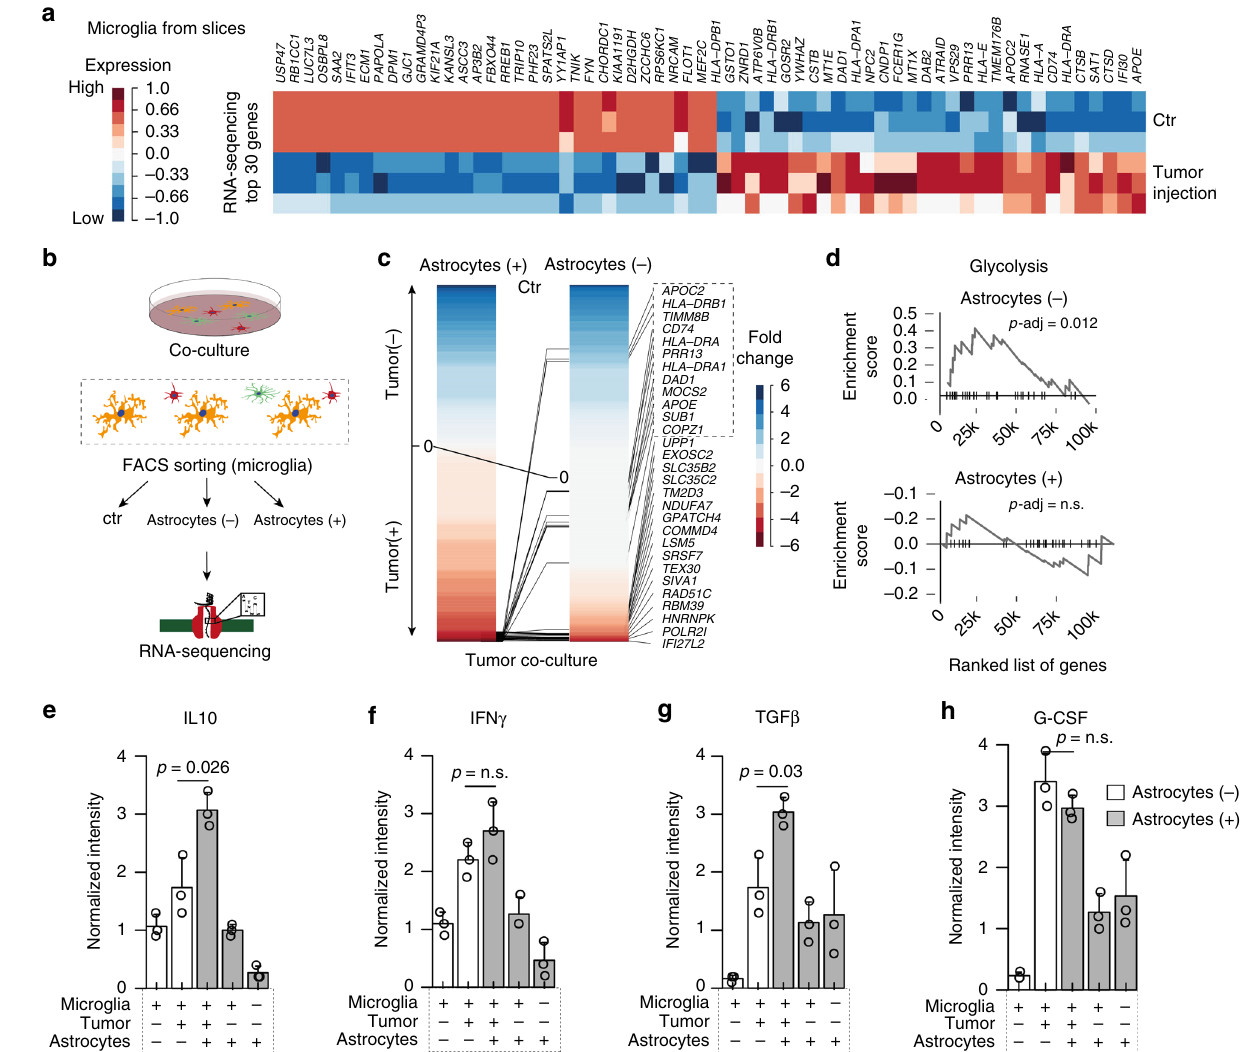
Fig. 5 Transcriptional pro fi ling of microglia from slices and a co-culture model. a AutoPipe unsupervised cluster and heatmap of 30 most representative genes expressed in microglia derived from control and tumor injected slices. b Illustration of the co-culture model. c Analysis of differentially expressed genes of puri fi ed microglia in Astrocytes ( + ) or Astrocytes ( − ) condition. Genes are ordered based of fold-change of gene expression, colored in blue for highly expressed in control samples and red for increased expression in tumor injected samples. Lines indicate the differences of the fold-change rank (top 30 genes) between Astrocytes ( + ) and Astrocytes ( − ) condition. d Gene Set Expression Analysis (GSEA) of ranked gene expression of Astrocytes ( + ) or Astrocytes ( − ) condition indicate the enrichment differences of the genes involved in glycolysis. e – h Bar plots of cytokine protein level in all conditions. Exact values, as well as statistical analysis are given in the source fi le. P -values are determined by one-way ANOVA e – h adjusted by Benjamini – Hochberger ( e – h ) or False-Discovery Rate ( d ) for multiple testing. Data is given as mean ± standard